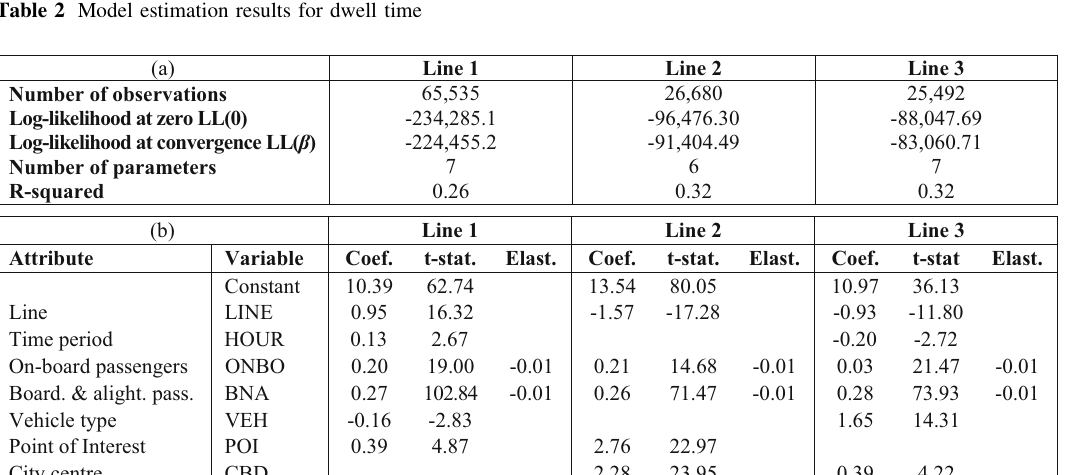
Table 2 Model estimation results for dwell